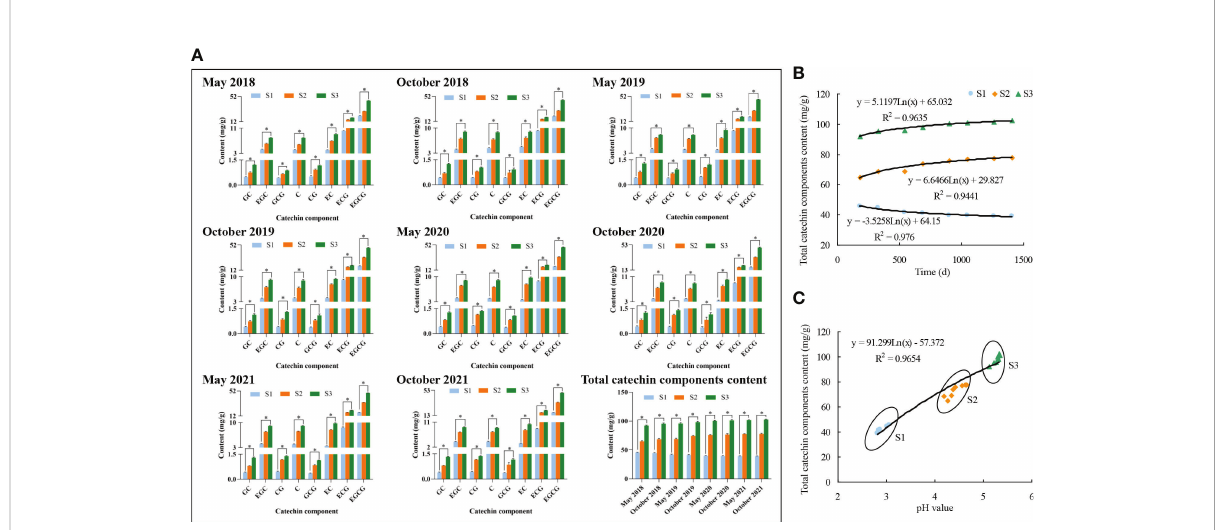
FIGURE 5 Effects of different fertilization treatments and soil pH on the content of catechin components in tea leaves. Note: S1: 100% Chemical fertilizer; S2:50% Organic fertilizer +50% chemical fertilizer; S3: 100% Organic fertilizer; GC, Gallocatechin; EGC, Epigallocatechin; CG, Catechin gallat; C, Catechin+C; GCG, Gallocatechin gallate; EC, Epicatechin; ECG, Epicatechin gallat; EGCG, Epigallocatechin gallate; (A) Changes of catechin content in tea leaves after continuous fertilization; (B) Trend analysis of the effect of 4 consecutive years of fertilization on the content of catechin components in tea leaves; (C) Trend analysis of the in fl uence of soil pH on the content of catechin components in tea leaves; * indicate the signi fi cant difference at P < 0.05 levels among different